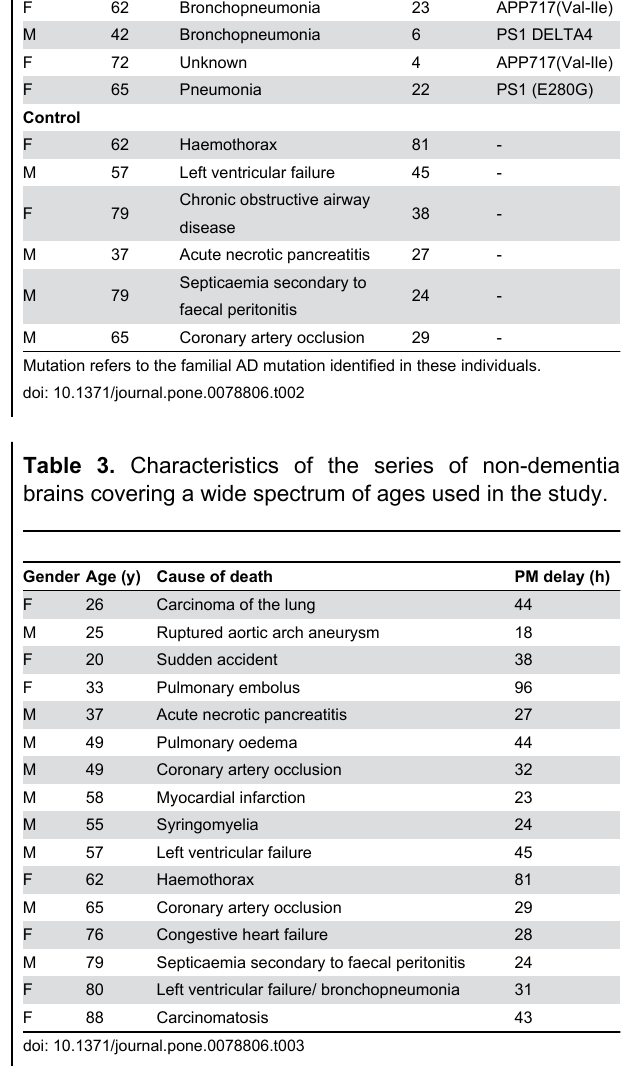
Table 2. Characteristics of the Familial AD and control cases used in the study.